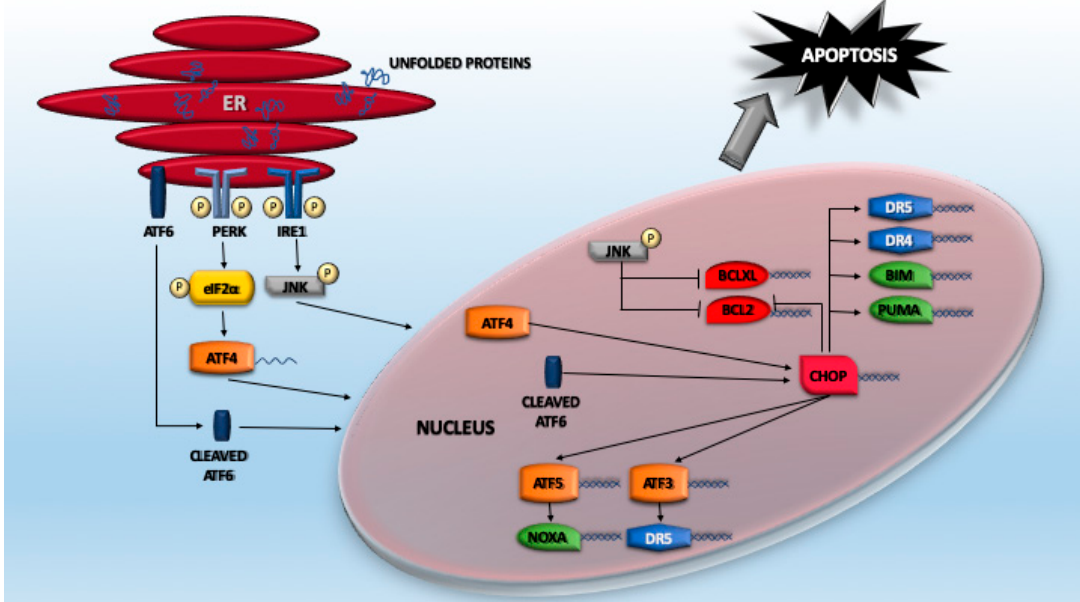
Figure 2. The activating transcription factor (ATF) network in response to proteotoxic stress.